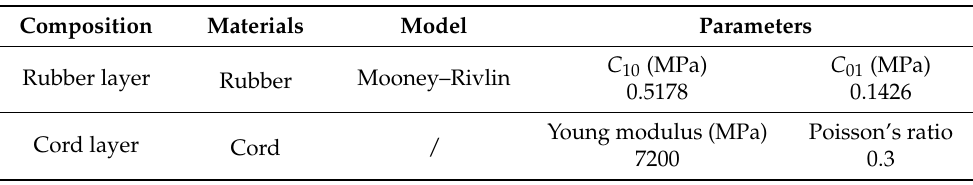
Table 1. Physical parameters of bellows